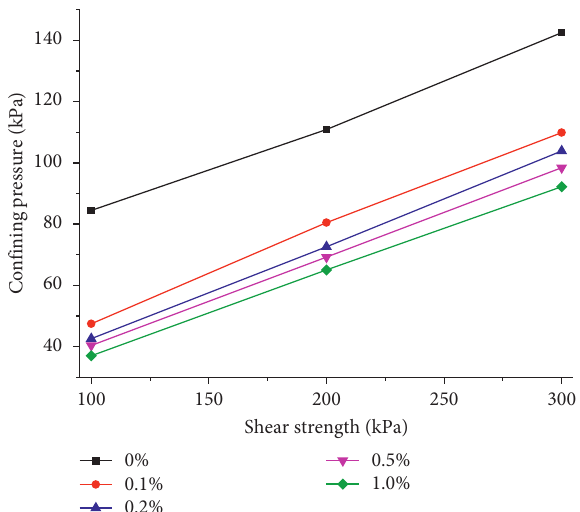
Figure 4: The curves between shear strength and confining pressure under different zinc ion concentrations.